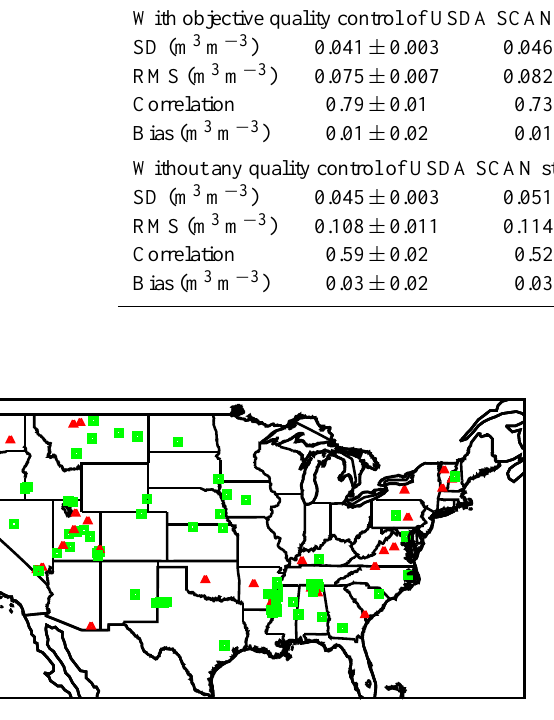
Fig. 11. Location of USDA SCAN stations measuring soil moisture. Green squares (red triangles) show locations where ASCAT surface soil wetness assimilation reduces (increases) the random difference (SD) between the UM level 1 soil moisture analyses and USDA SCAN in-situ soil moisture observations. Most locations show an improvement in the UM soil moisture analyses (green squares). However, a degradation of the UM soil moisture analyses for the US East coast is suggested by the concentration of red triangles in that area.